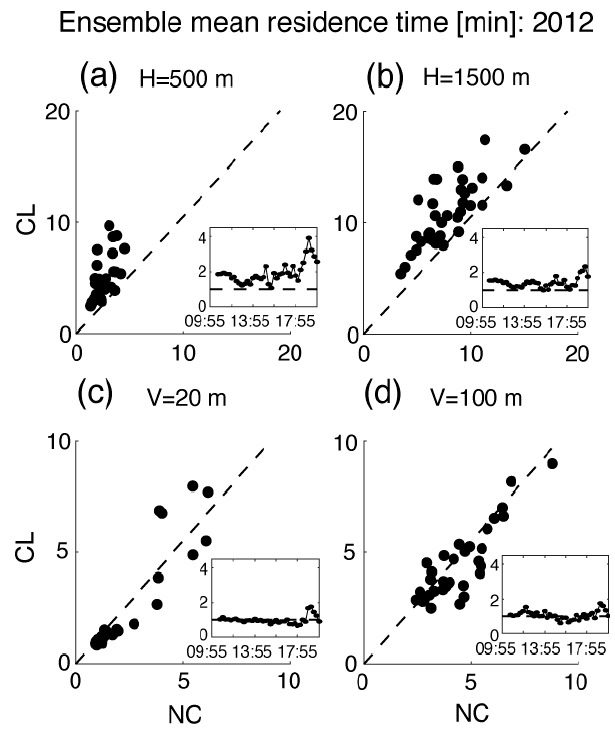
Figure 11. As in Figure 7, but for the 2012 case.